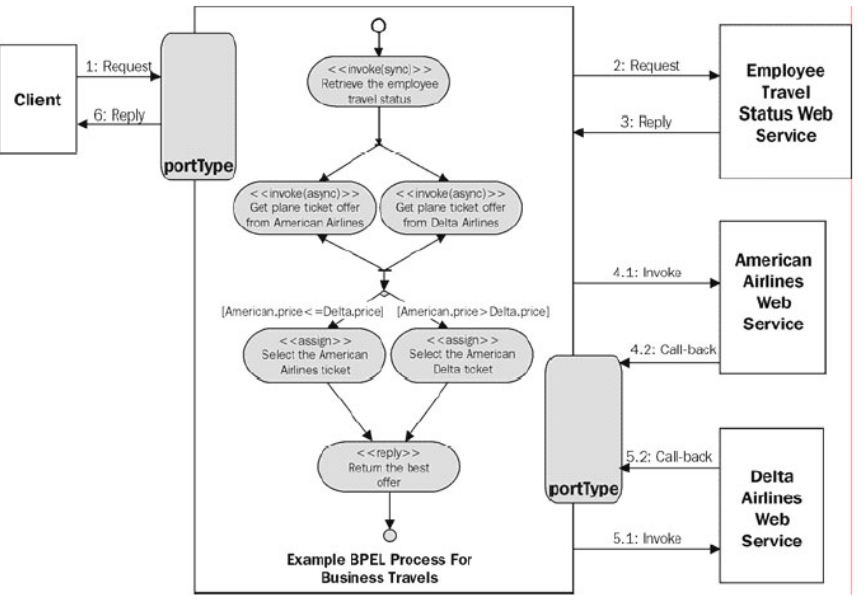
Figure 7. Example BPEL process for travel